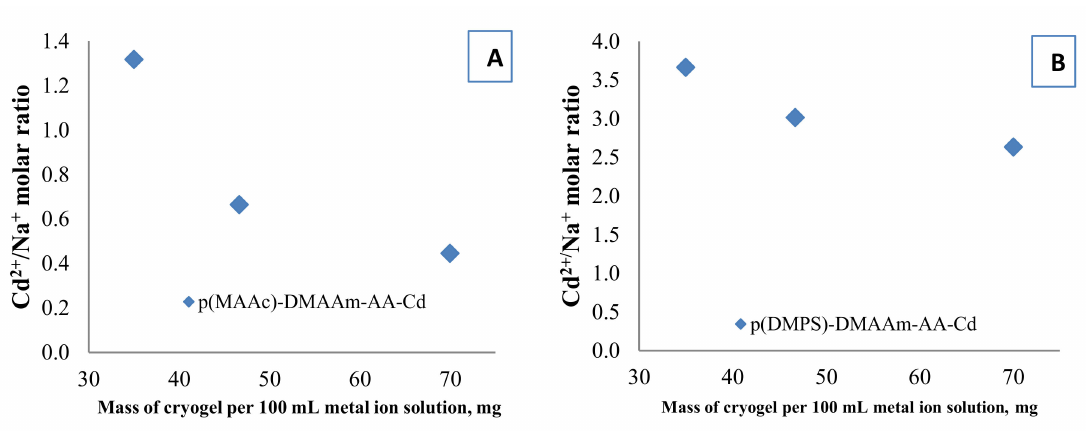
Figure 7. Cd 2 + / Na + molar ratio in selected experiments for ( A ) p(MAAc)-DMAAm-AA-Cd and ( B ) p(AMPS)-DMAAm-AA-Cd (right)